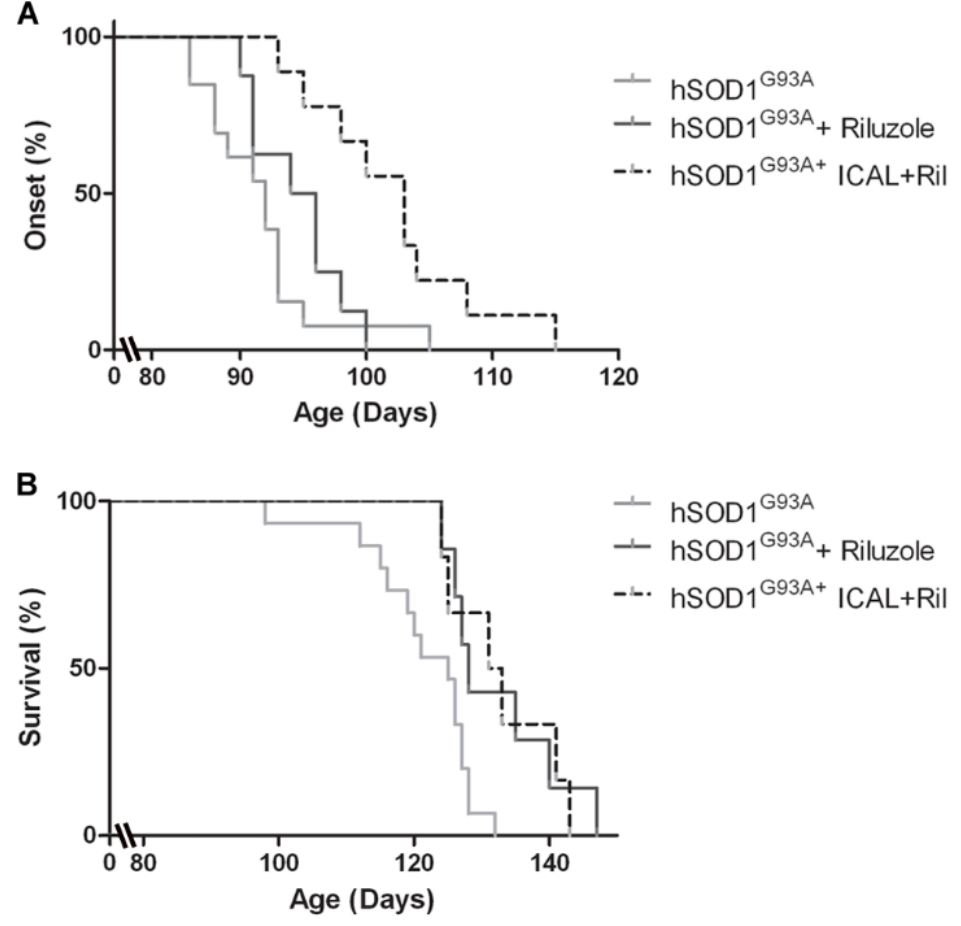
Figure 6. Treatment with Immunocal ® an riluzole significantly delays disease onset and extends survival in hSOD1 G93A mice. ( A ) hSOD1 G93A mice receiving riluzole beginning at 60 days of age (pre-symptomatically) show no delay in disease onset and clinical decline compared to untreated mutant mice ( n = 8). hSOD1 G93A mice receiving riluzole in addition to Immunocal ® showed a significant delay in disease onset and clinical decline compared to untreated mutant mice ( p < 0.001; n = 10). Onset curves were compared pair-wise using the Gehan–Breslow–Wilcoxon test. ( B ) hSOD1 G93A mice receiving riluzole beginning at 60 days of age (pre-symptomatically) showed a significant extension in survival compared to untreated mutant mice ( n = 7; p < 0.05). Similarly, hSOD1 G93A mice receiving riluzole in addition to Immunocal ® showed a significant extension in survival compared to untreated mutant mice ( p < 0.05; n = 8). Survival curves were compared pair-wise using the Gehan–Breslow–Wilcoxon